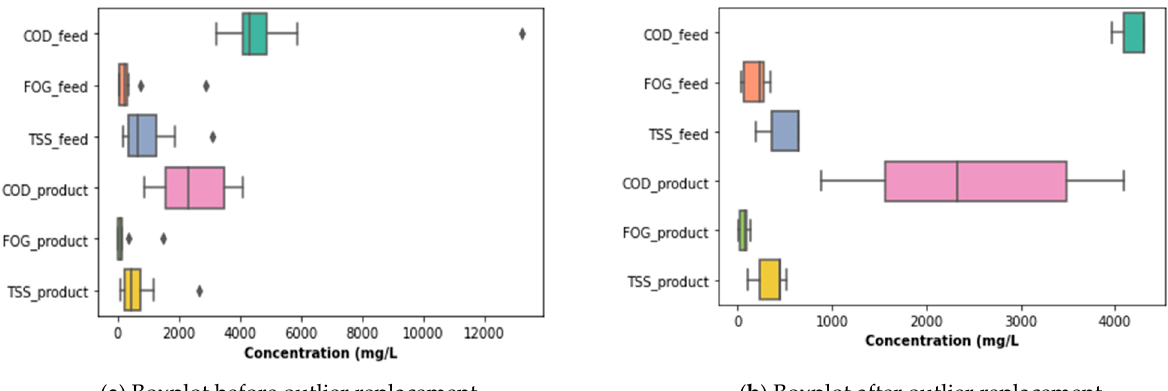
Figure 7. Boxplots of the distributions of TSS, FOD, and COD before and after outlier replacement.